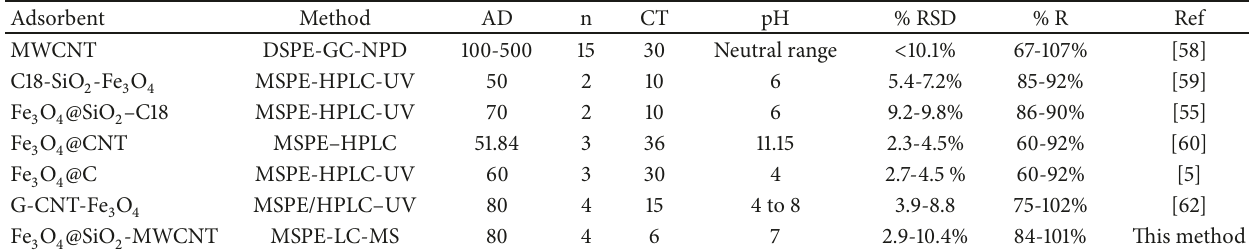
Table 4: Comparison of current work for pesticide extraction with reported literature materials.